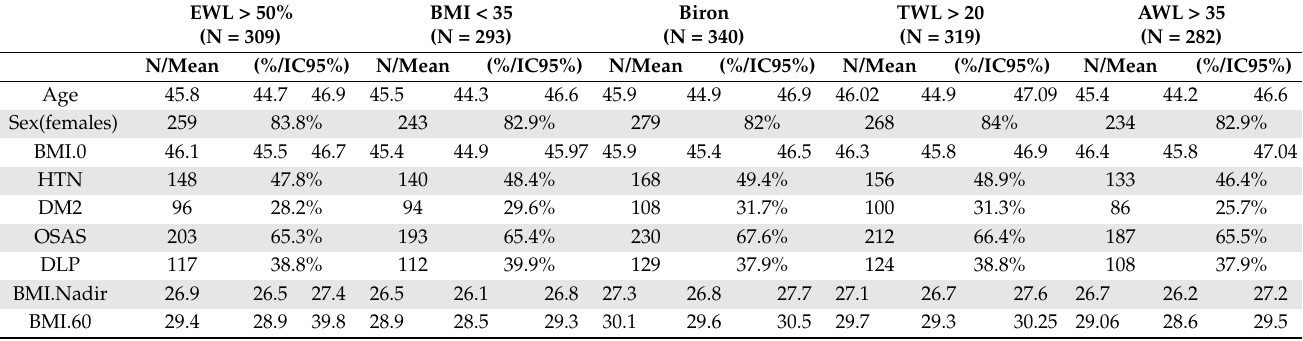
Table 4. Success rates for different criteria at 5-year follow-up for Roux-Y-gastric bypass interventions. Data are reported as mean and 95% confidence interval (CI 95%) or n (%). N, number of individuals; sex is expressed by the number of female patients. BMI.O, BMI before surgery; BMI.nadir, BMI at nadir post-bariatric surgery; BMI.60, BMI at 5-year post-bariatric surgery; HTN, hypertension;